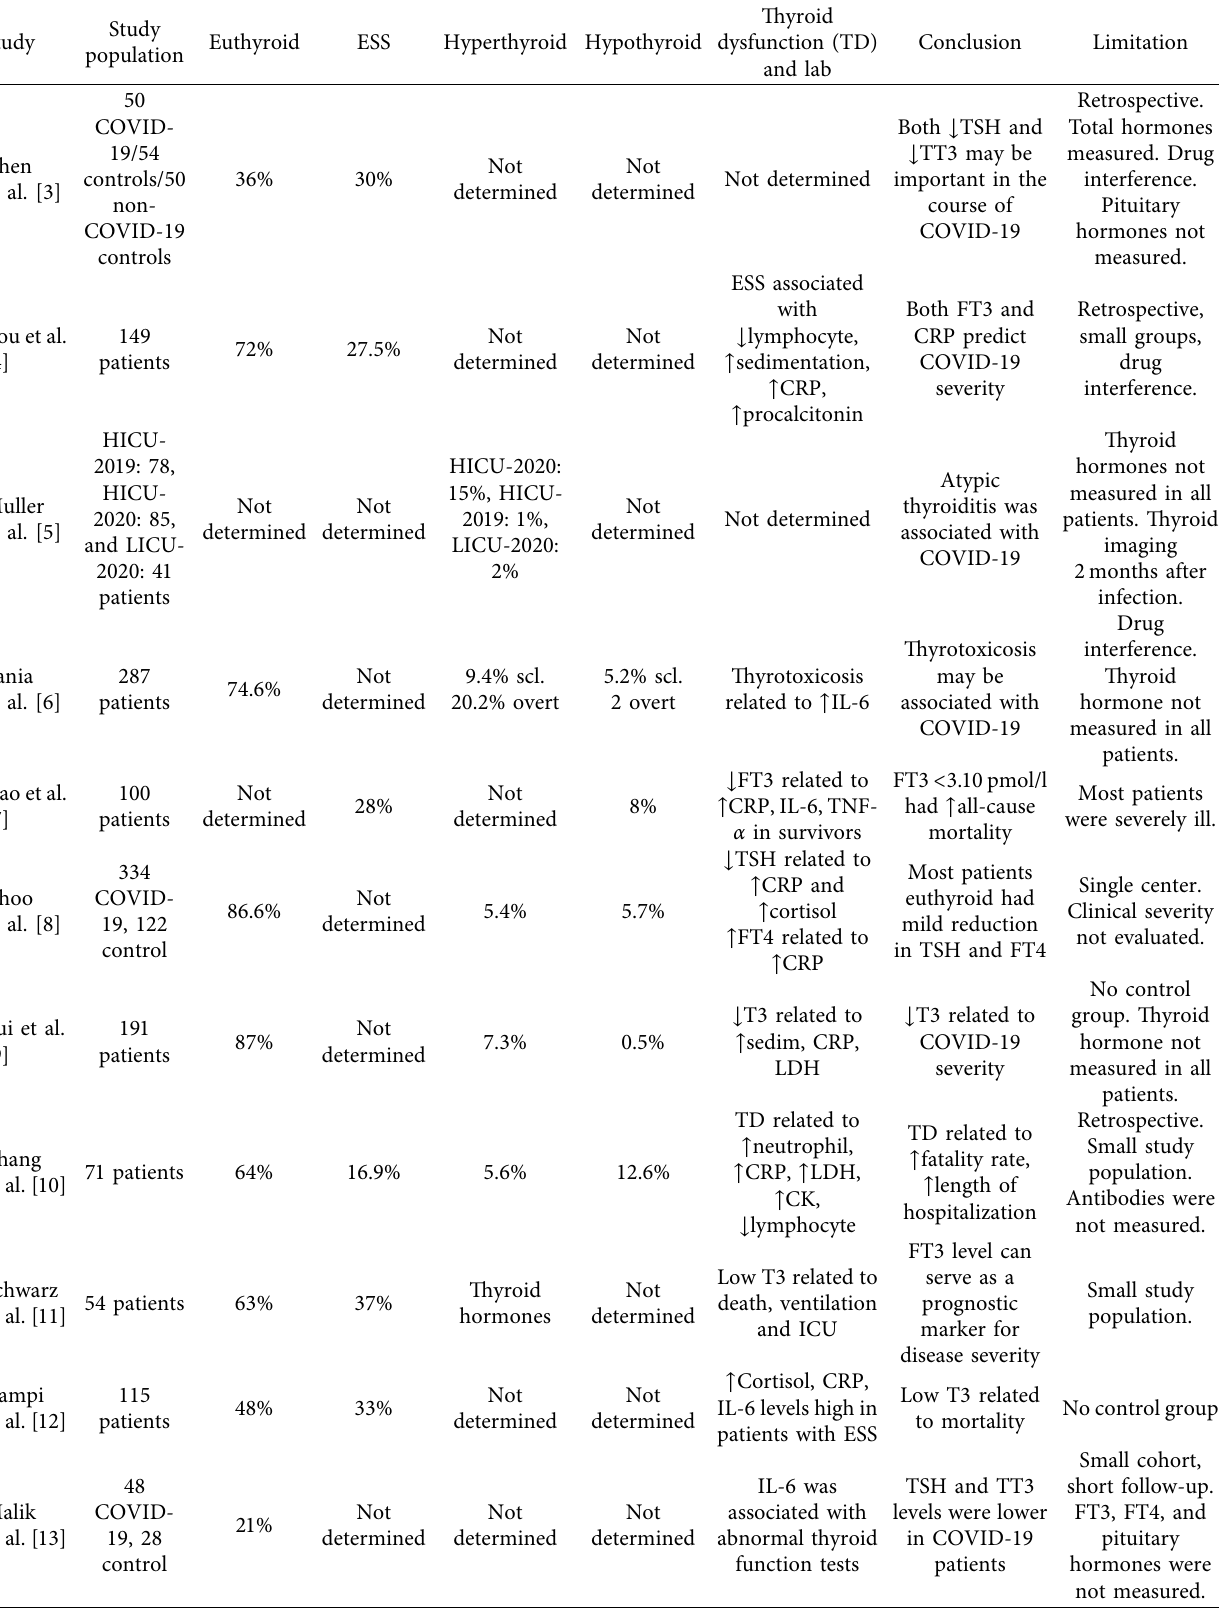
Table 1: Evaluation of clinical studies about thyroid and COVID-19